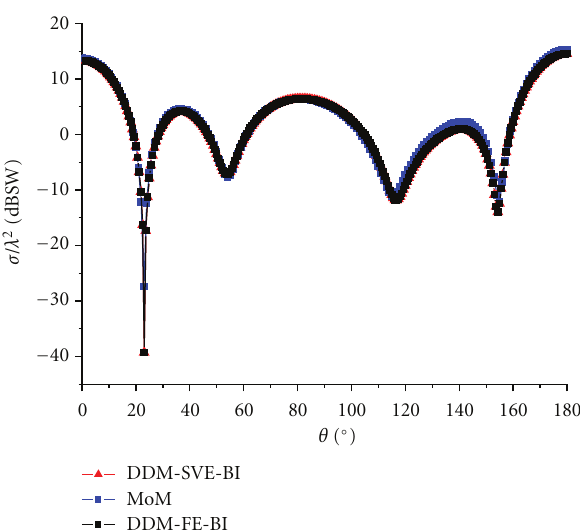
Figure 4: Two dielectric spheres.